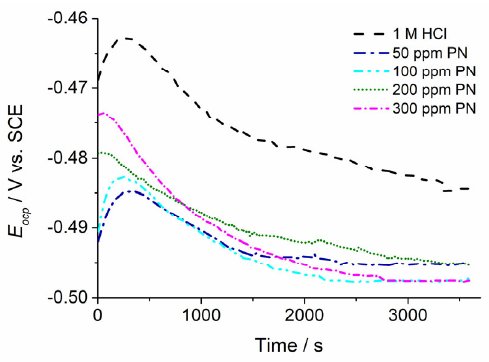
Figure 3. Open circuit potential curves of carbon steel without and with different concentrations of essential oil PN in 1 M HCl.